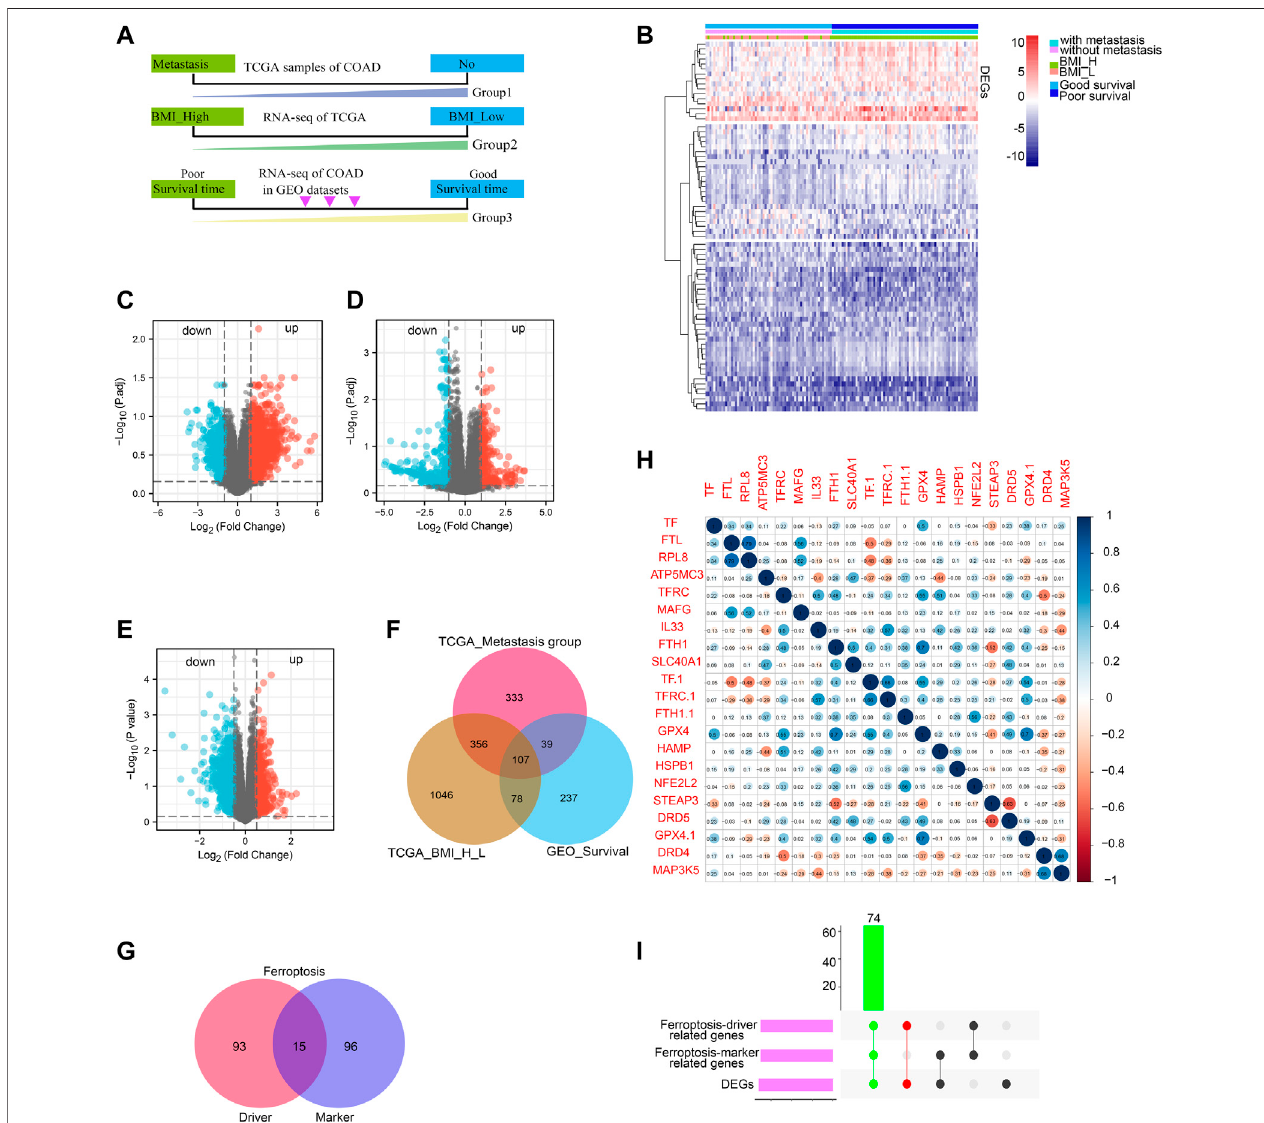
FIGURE 1 | Screening of ferroptosis-related DEGs. Work fl ow of screening based on TCGA COAD metastasis, BMI value and survival status of GEO COAD patients, respectively (A) ; heat map of DEGs based on TCGA COAD metastasis, BMI value and survival status of GEO COAD patients (B) , different bars indicated different group; Volcanic map of DEGs, red represents upregulated genes while blue represents downregulated genes (C – E) ; Venn diagram showing upregulated overlappingDEGsbasedonTCGACOADmetastasis,BMIvalueandsurvivalstatusofGEOCOADpatients,respectively (F) .Ferroptosis-driver and-markergenes wereshownwithvenndiagramfromFerrDbdatabase (G) ;Ferroptosis-drivergeneswere108;Ferroptosis-markergeneswere111;theintersectedgenesco-expressed betweenferroptosis-driverand-markergeneswere15;ThecorrelationbetweenDEGsandferroptosis-relatedgeneswasshownwithrepresentativecorrelationplot (H) ; Blue bar indicated: R (sperman ’ s coef fi cient) > 0; red bar indicated: R (sperman ’ s coef fi cient) < 0; The DEGs correlated positively with ferroptosis-driver and -marker genes were presented with UpsetR diagram (I) ; green bar indicated the fi nal ferroptosis-related genes.